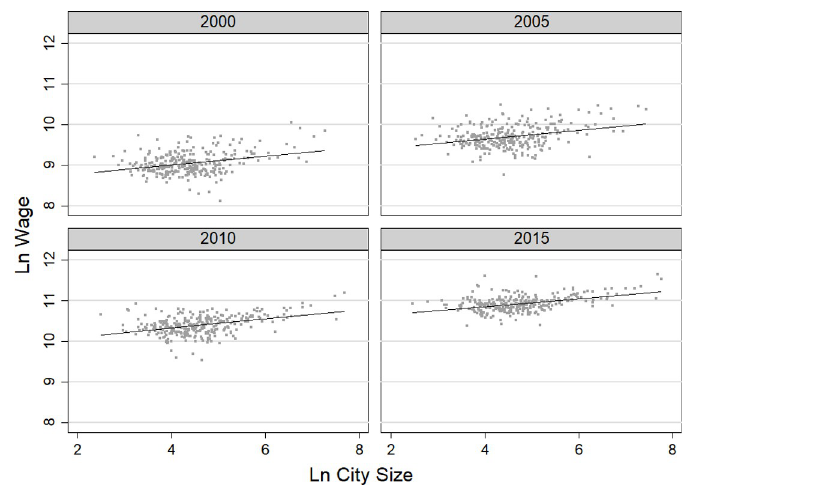
Fig 3. Changes in wage premium of migrants from 2000 to 2015.